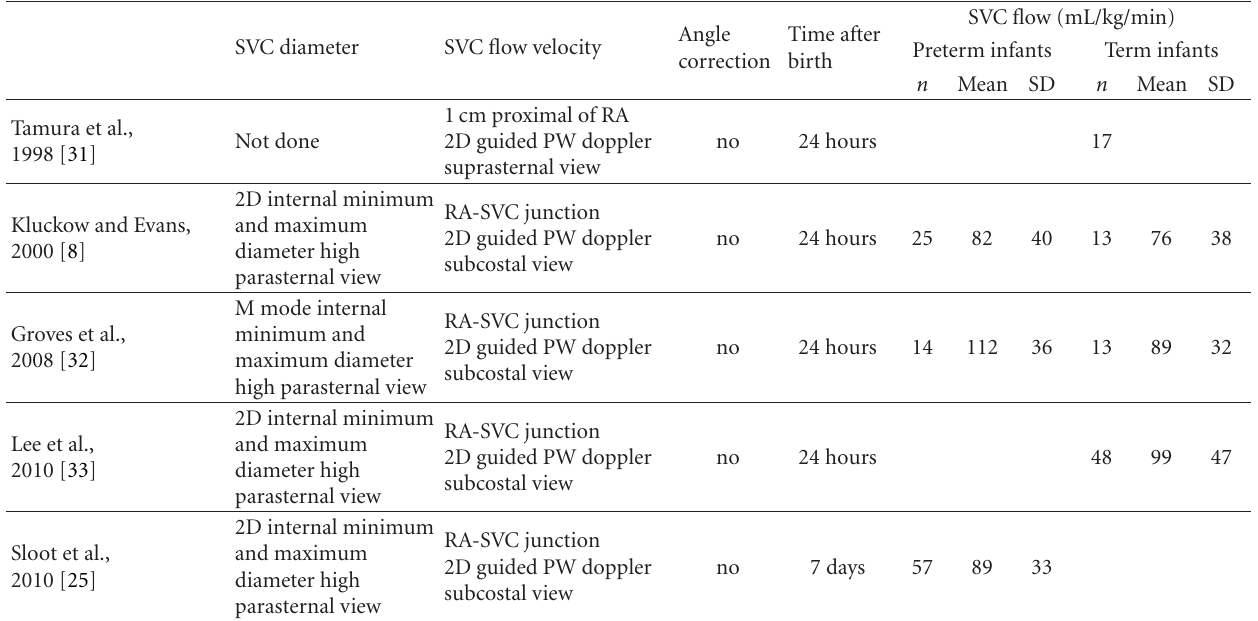
Table 3: Methods of determination of SVC diameter, flow velocity, and reported mean (SD) values in mL/kg/min.